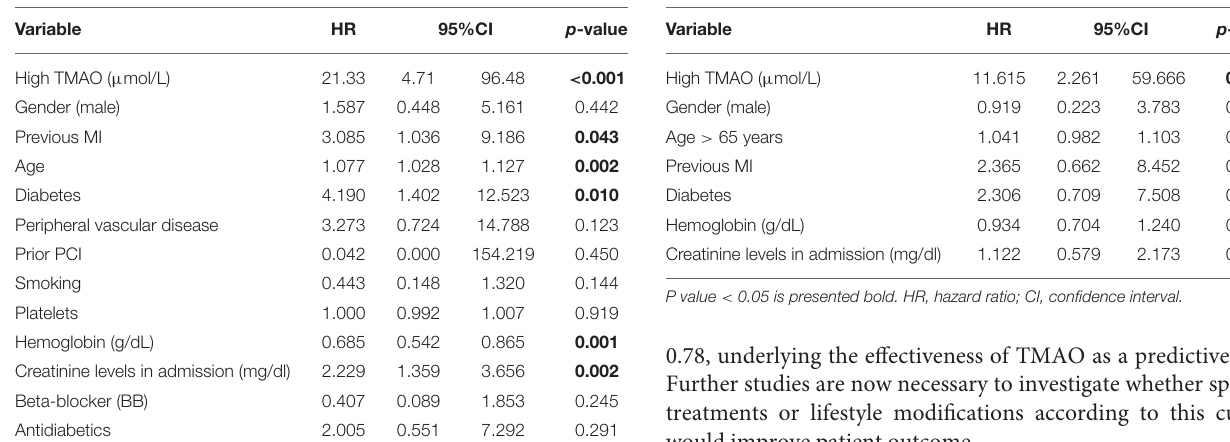
TABLE 6 | Multivariate Cox regression model for prediction of long-term cardiovascular